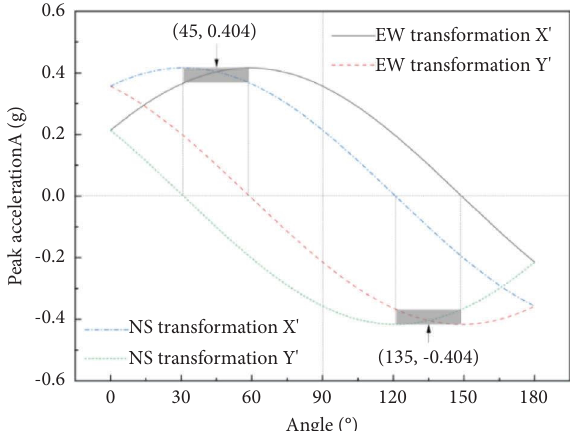
Figure 9: Coordinate transformation peak acceleration.